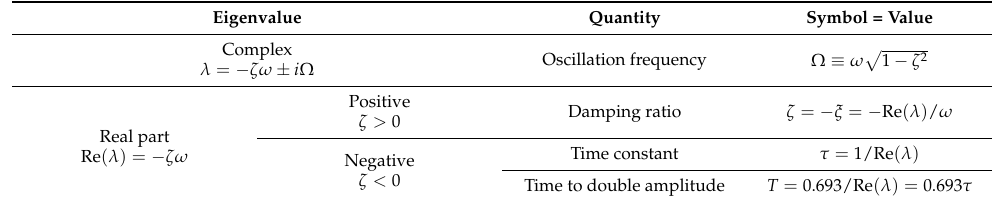
Table 8. Eigenvalues of the stability matrix ( ω —natural frequency; ζ —damping ratio; ξ —amplification ratio).